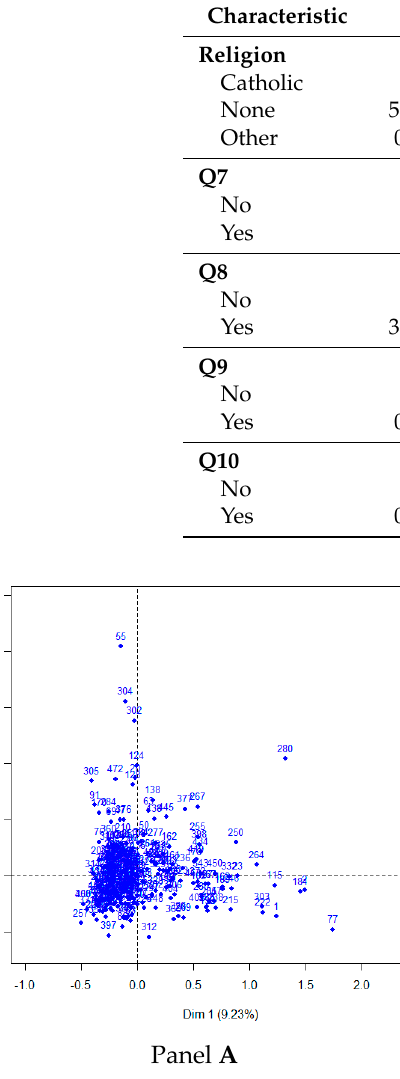
Figure 1. Multiple correspondence analysis. Observations and variables factor map are reported in panels ( A ) and ( B ), respectively.